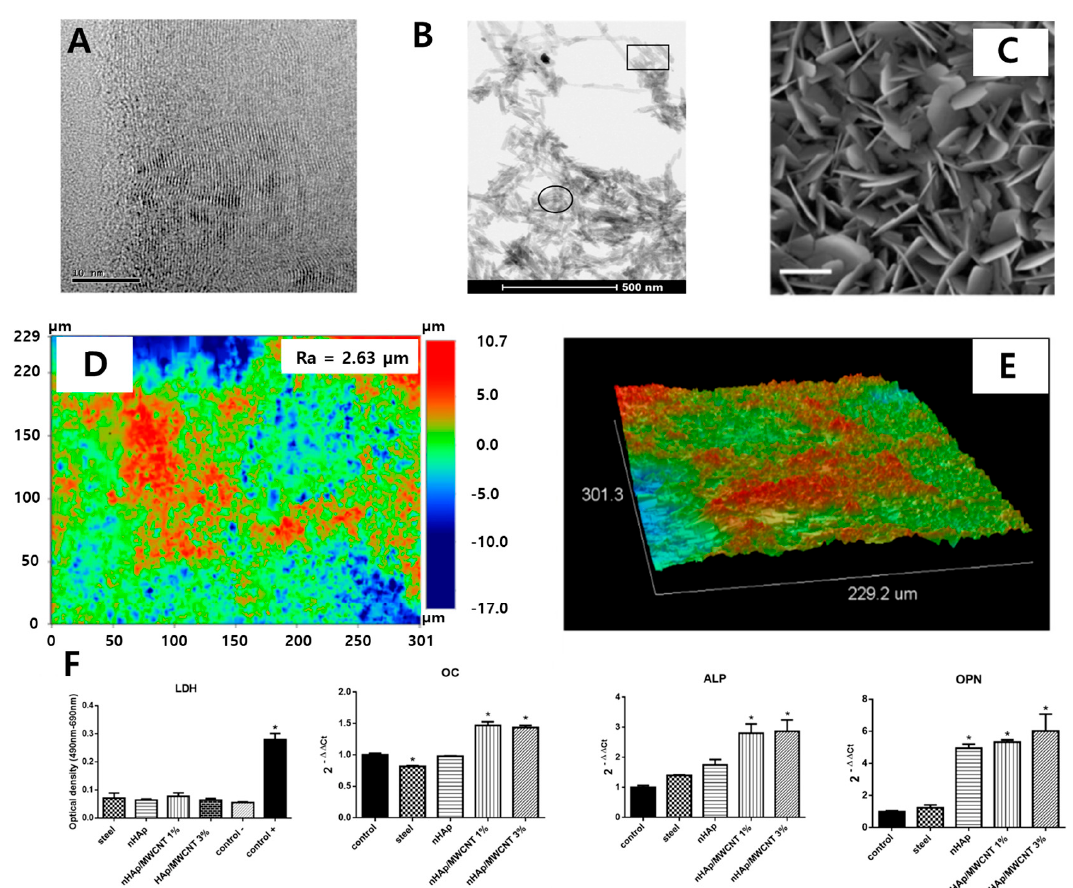
Figure 7. CNT/MNCNT composite-coated 316L stainless steel alloys. ( A ) Transition electron microscopy of MWCNT. ( B ) SEM of nano HAp-deposited MWCNT. The square illustrates the MWCNT covered by nHAp crystals, and the circle illustrates a region containing pure nHAp crystals. ( C ) SEM, ( D ) optical images from profolometry, and ( E ) 3D constructions extracted from profilometry of nanoHAp/MWCNT-deposited 316L stainless steel. ( F ) Intracellular lactate dehydrogenase (LDH) release and expression of osteogenesis-related genes (OC: osteocalcin, ALP, OPN). An asterisk (*) denotes significant difference compared to the control of the same day. Data reproduced from Ref. [96]. Copyrights MDPI